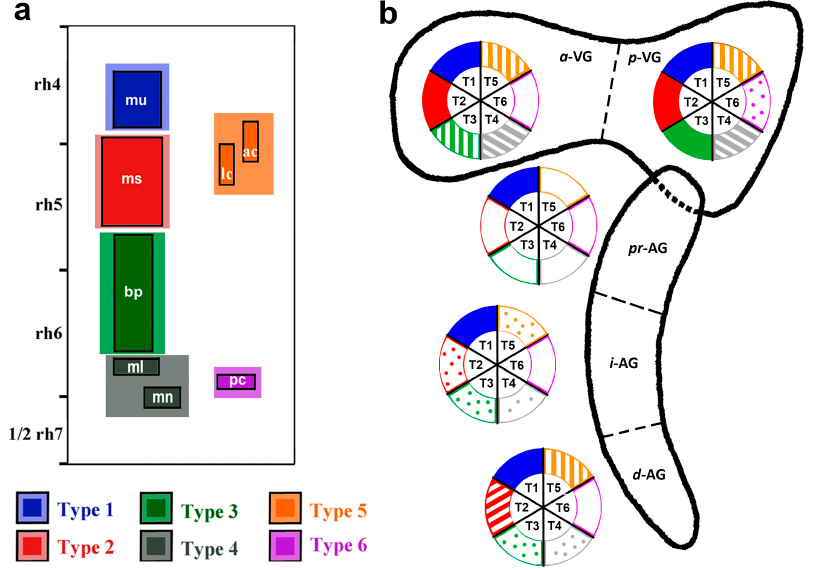
Figure 7. Avian otic placode schematic representation at stage HH10 (10 somites), showing the grafted ectoderm portions of each transplant type. ( b ) Schematic representation displaying the neuronal contribution of each graft type to the different acoustic–vestibular ganglion portions (a-VG, p-VG, pr-AG, i-AG, and d-AG). Each graft type is represented by the same color code used in ( a ). The neuronal contribution of each graft is denoted as high (full colored), medium (stripes), low (dots), or no contribution (white).